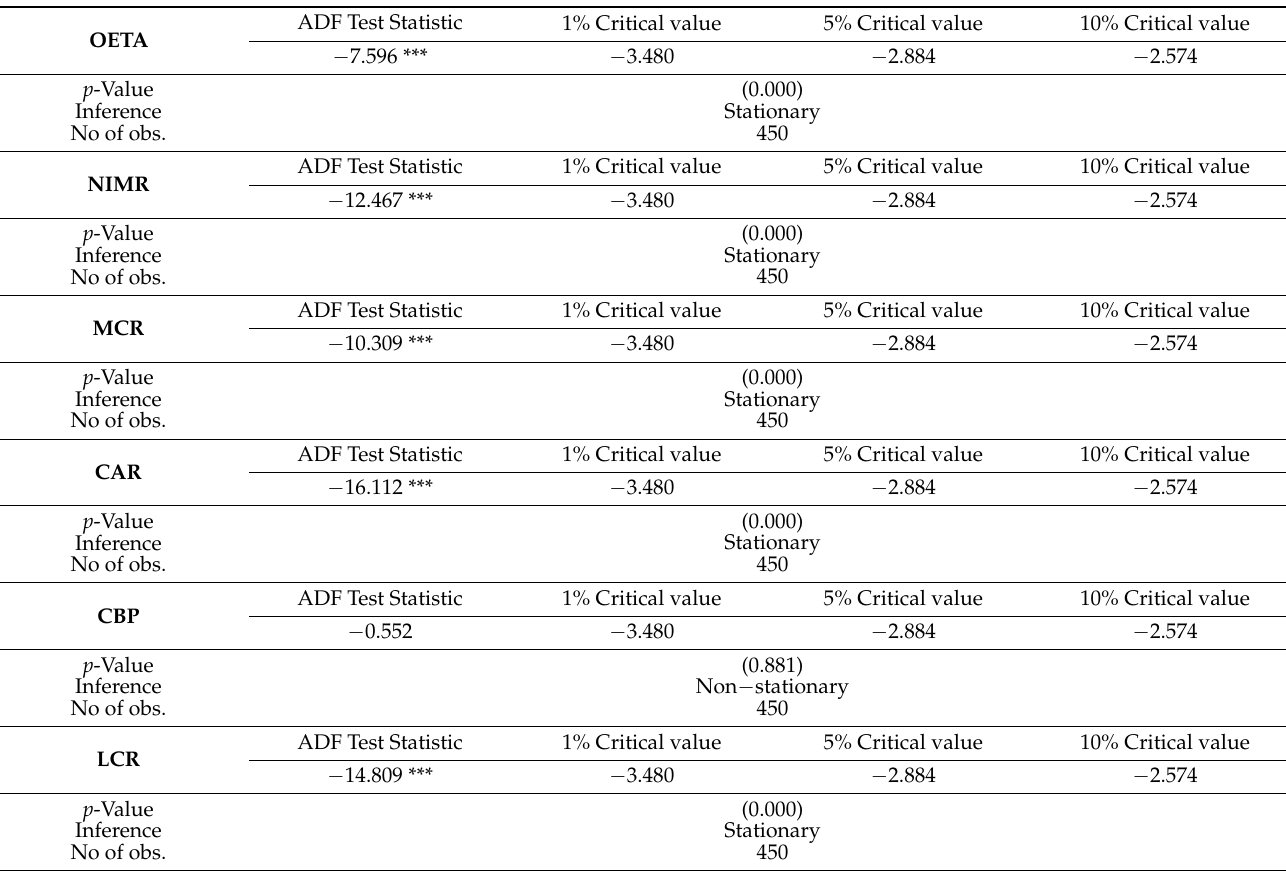
Table A2. ADF Test